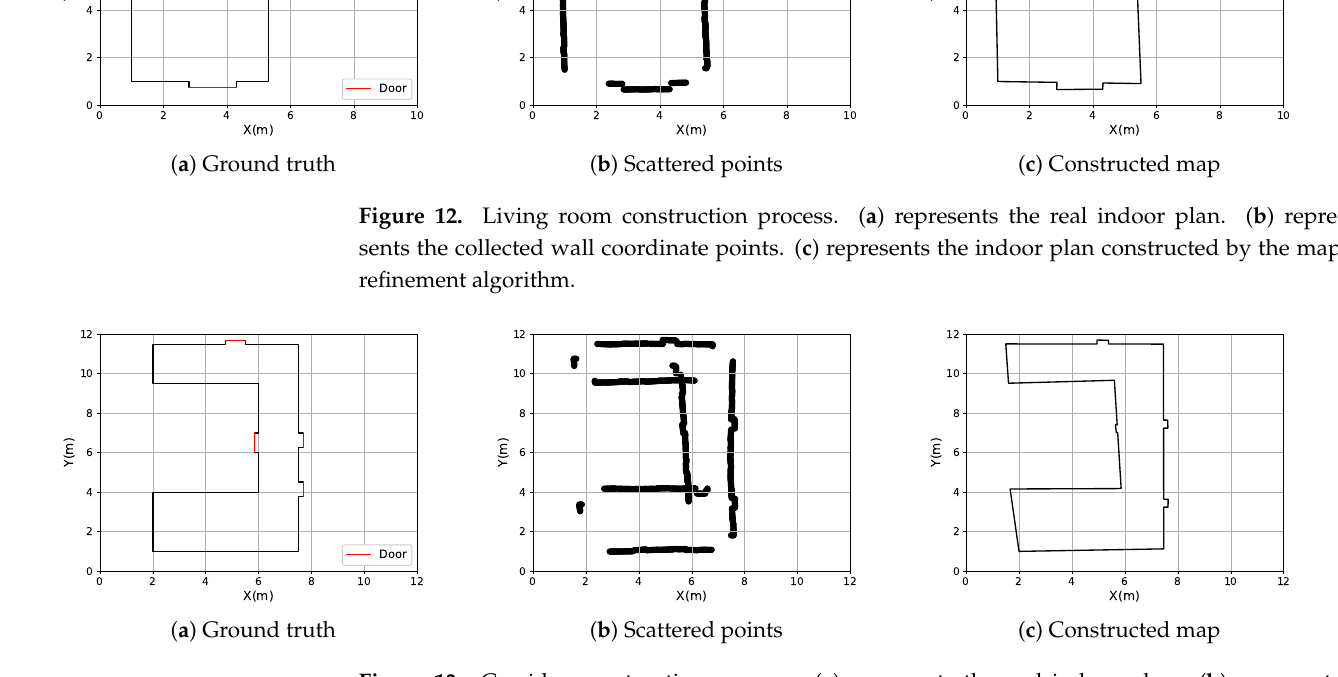
Figure 13. Corridor construction process. ( a ) represents the real indoor plan. ( b ) represents the collected wall coordinate points. ( c ) represents the indoor plan constructed by the map refinement